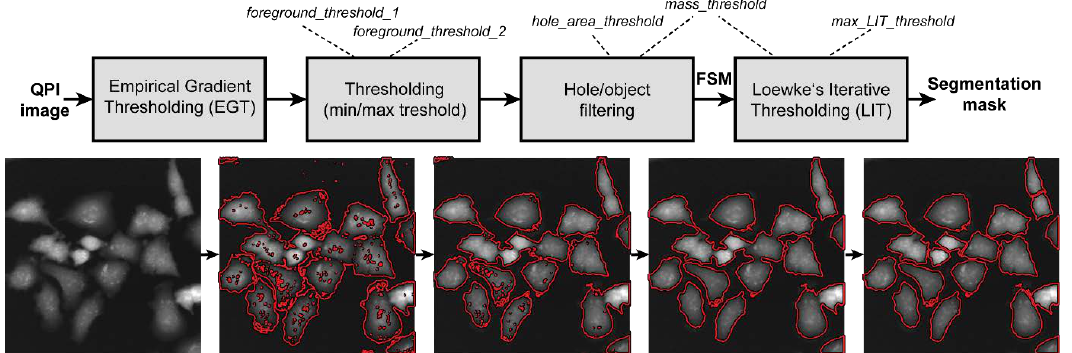
Figure 2. Block diagram of the cell segmentation algorithm. The process consists of two main steps–foreground segmentation (semantic segmentation) and single-cell separation (instance segmentation). Foreground segmentation uses EGT algorithm [34], where the result is refined with additional thresholding and object/hole filtering. Single-cell separation uses LIT algorithm [33]. Input parameters to individual steps are shown with dashed arrows. FSM, Foreground Segmentation Mask; QPI, Quantitative Phase Imaging.